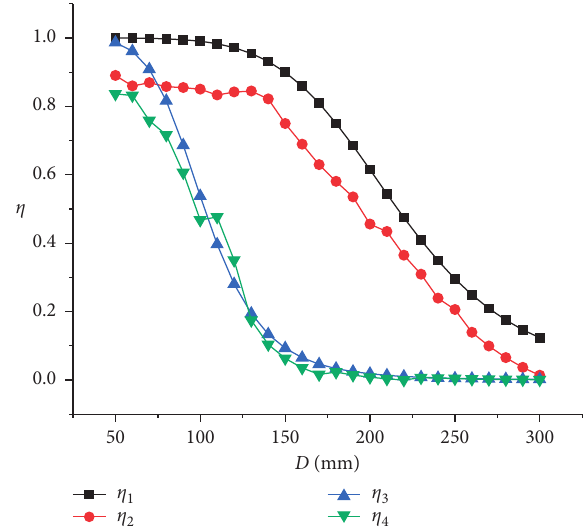
Figure 9: Simulation and experimental efficiency comparison